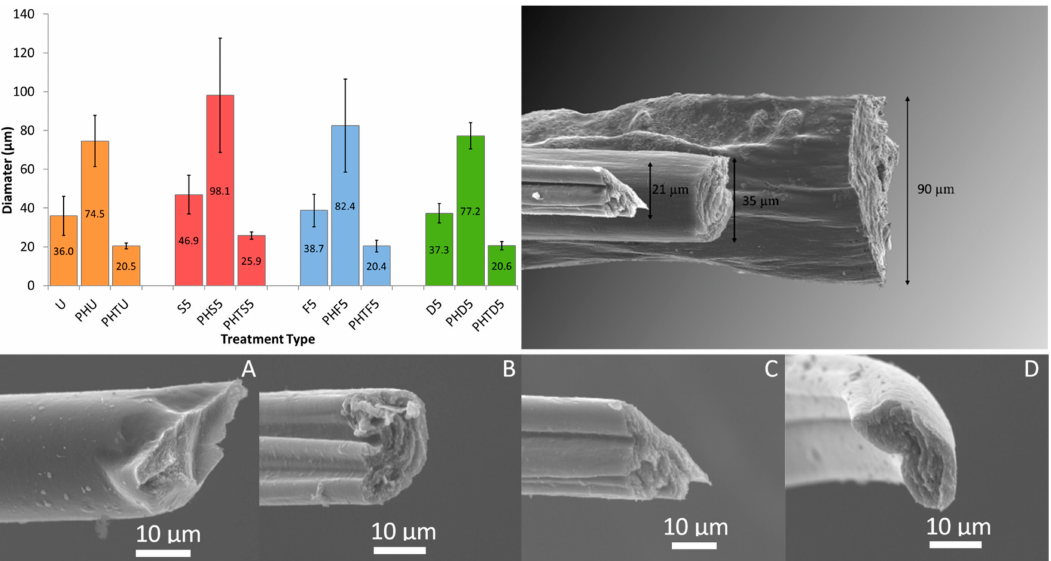
Figure 3. Averaged diameter values comparing Orgacon PEDOT:PSS fibers with both diameters of Clevios PH1000 fibers for 5 min treatments ( top left ) (n = 10). SEM graphic comparing the three fiber types ( top right ). SEM images of fiber cross-sections PHTU ( A ), PHTS5 ( B ), PHTF5 ( C ), PHTD5 ( D ).